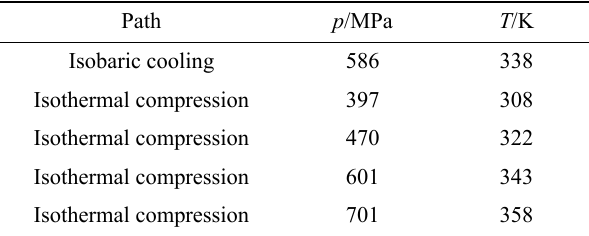
Table 1 The glass transition state (pressure and temperature) from experiment.